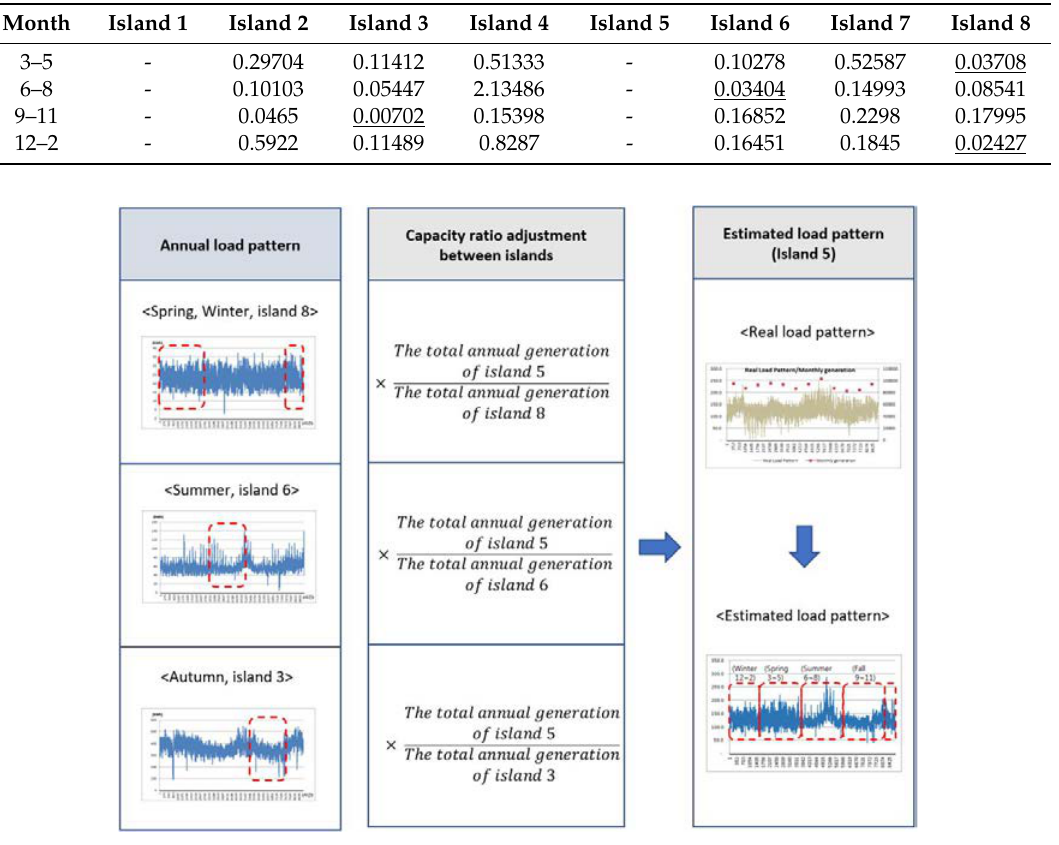
Table 3. Total squares of difference of normalized sum of power consumption by two month periods between Island 5 (to be estimated) and the rest of islands.